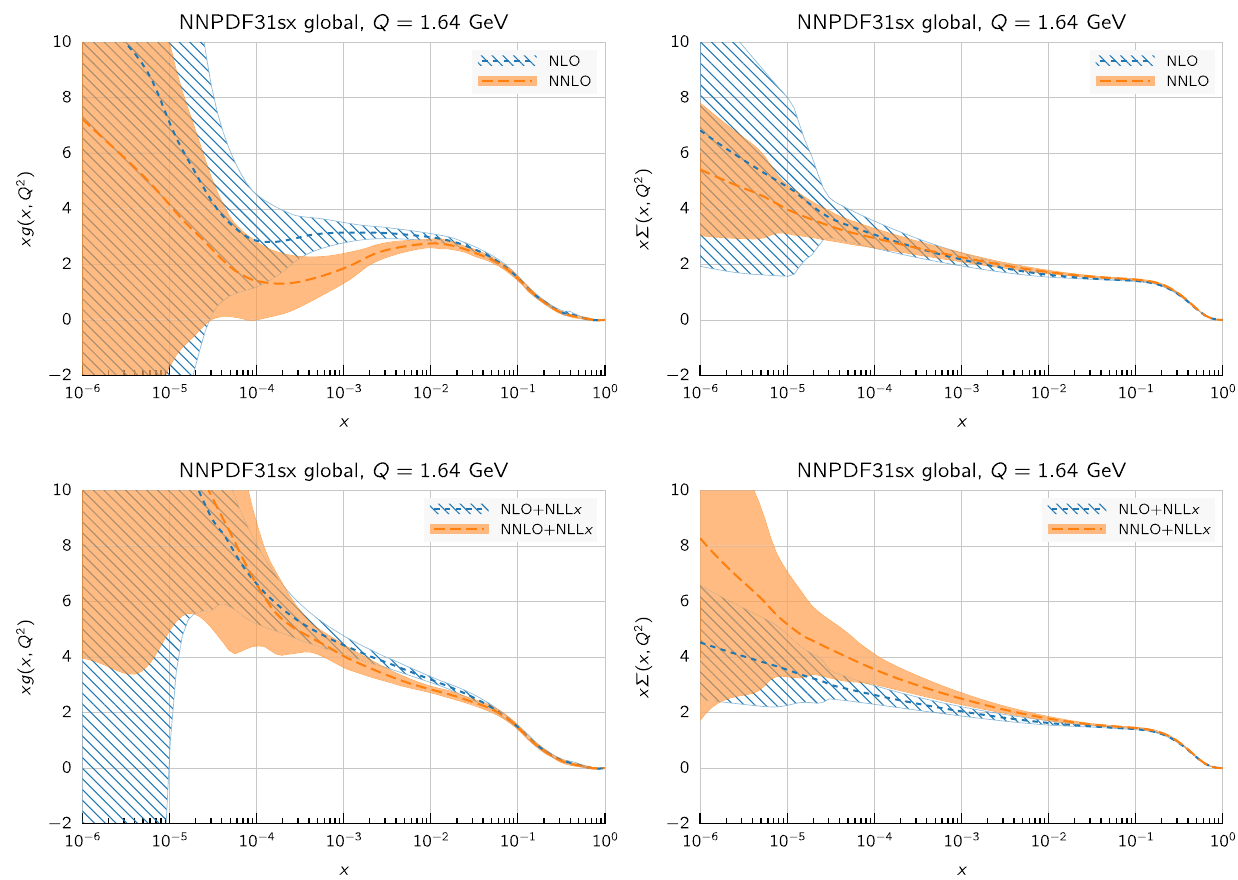
Fig. 16 Comparison of NLO and NNLO fit results at the input parametrization scale of Q = 1 . 64 GeV (upper plots), and of NLO+NLL x and NNLO+NLL x fit results at the input parametrization scale of Q = 1 . 64 GeV (lower plots). Left plots: gluon; right plots: quark